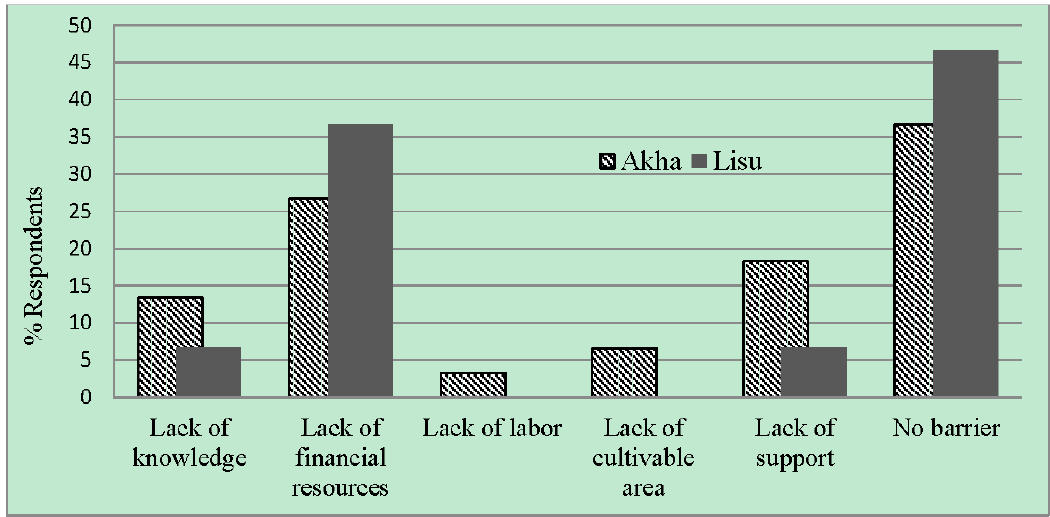
Figure 8. Barriers for adaptation to climate change.